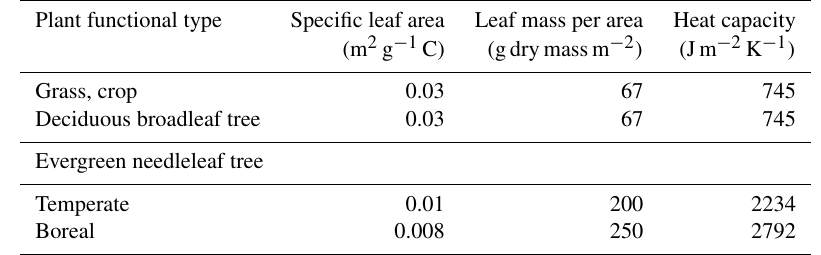
Table 1. Leaf heat capacity.